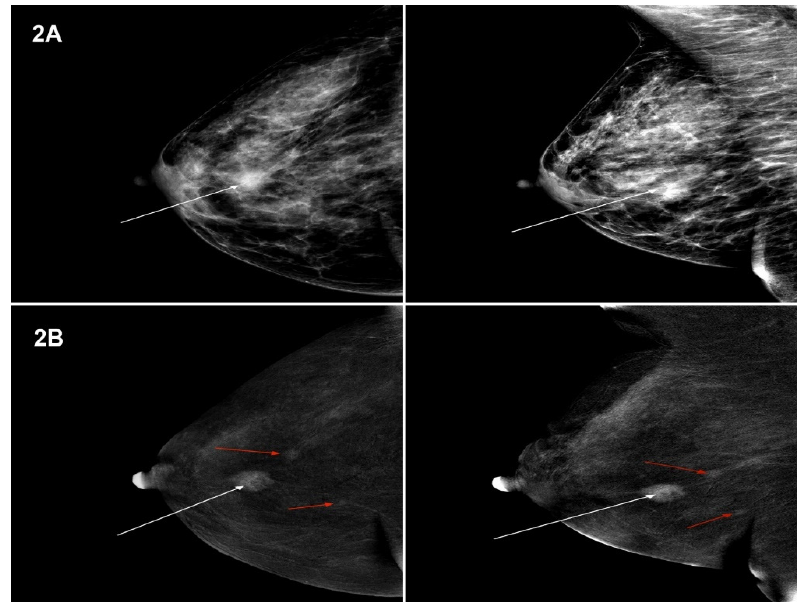
Figure 2. ( A ) MG (low-energy images)—tumour in the right breast, in the central part, measuring 16 mm—BI-RADS 6 (white arrow). Projection: CC and MLO, HP-Ca lobulare GIII. ( B ) CESM (subtraction images)—tumour in the right breast, in the upper external quadrant, measuring 15 mm, enhanced upon contrast injection—BIRADS 6, HP: Ca lobulare GIII (white arrow). Foci of amorphous contrast enhancement of a focal type, measuring 6 mm and 5 mm, at a distance of 12 mm and 26 mm from the tumour—BI-RADS 4 (red arrows). Projection: CC and MLO, HP-Ca lobulare GIII.